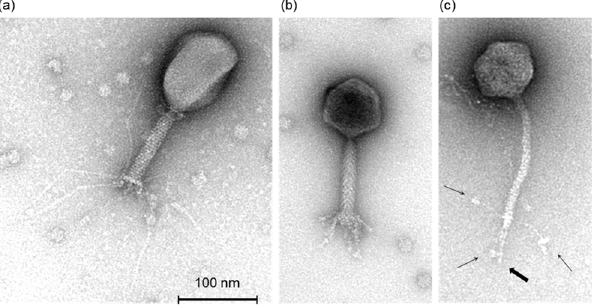
Fig 1. Transmission electron micrographs of E . coli phages ɸ APCEc01 (a), ɸ APCEc02 (b), and ɸ APCEc03 (c). The thin arrows in micrograph c indicate the 3 flexible fibres attached to the distal end of the phage tail. The terminal baseplate spike in c is illustrated by the thick arrow.